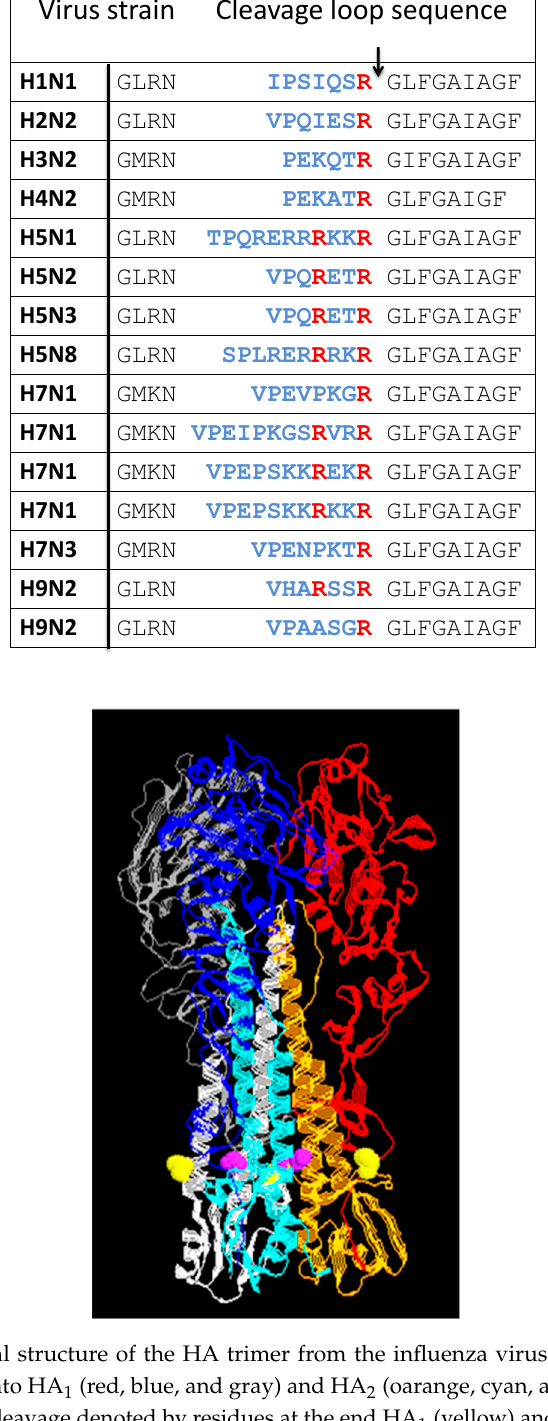
Table 5. Cleavage loop in the HA protein of influenza viruses. The variable region is blue with the arrow denoting the cleavage site. The P4Arg and P1Arg residues are colored red.